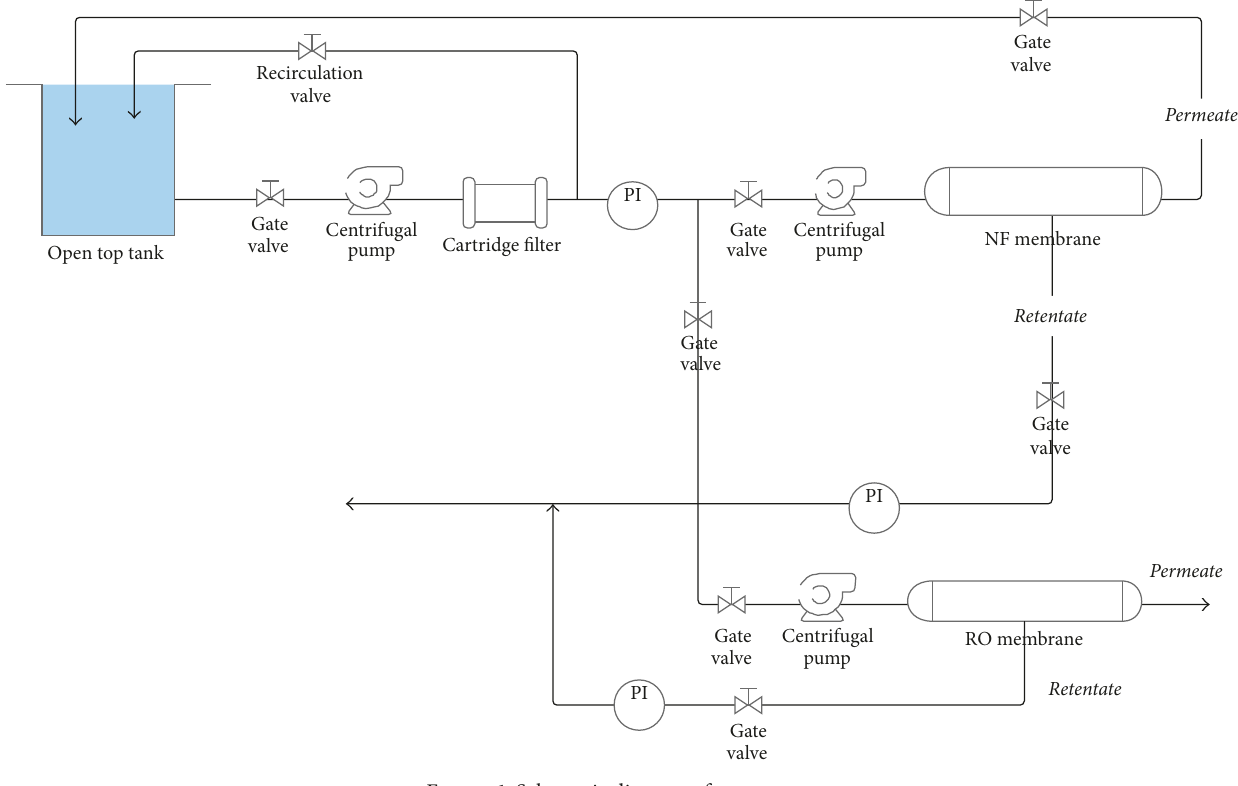
Figure 1: Schematic diagram of test system.